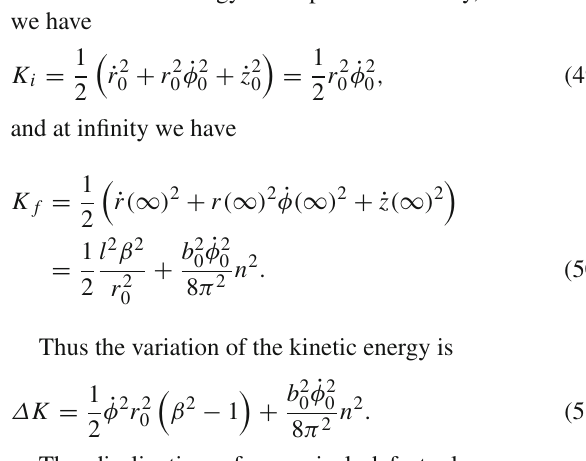
classical kinetic energy of the particle. Initially, when t = 0,